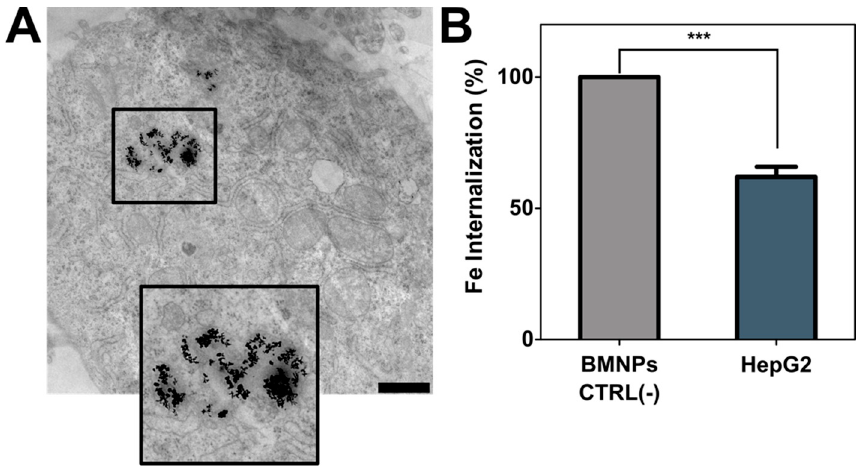
Figure 4. Nanoparticles’ internalization. ( A ) HepG2 cell micrography by TEM with BMNPs endoci- tated. Scale bar corresponds to 1 µ m. ( B ) Analysis of quantity of BMNPs uptaken by HepG2 cells (BMNPs CTRL corresponds to the control without cells). These experiments were conducted twice in triplicates. p ≤ 0.001 (***). Pharmaceutics 2021 , 13 , x FOR PEER REVIEW